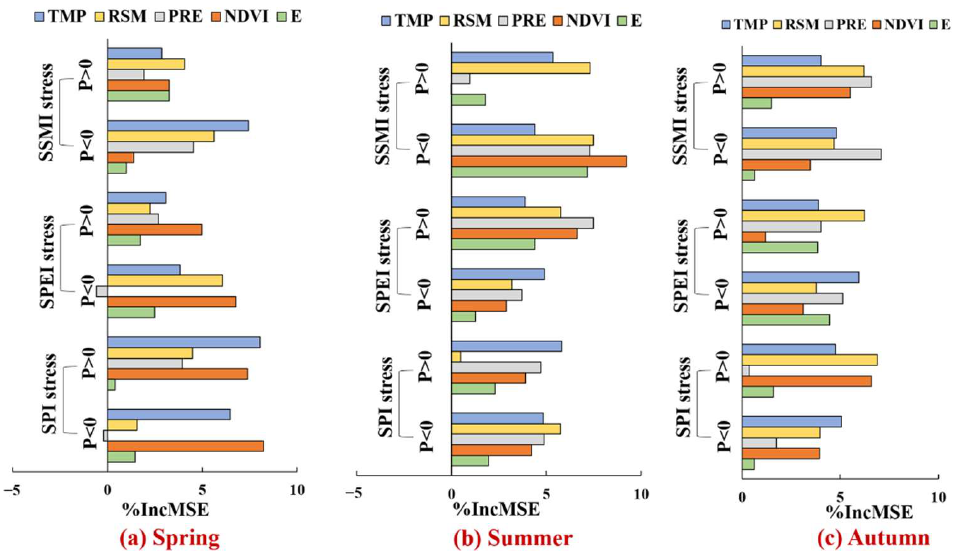
Figure 8. Importance score of different influencing factors on vegetation vulnerability changes under SPI/SPEI/SSMI stress: ( a ) spring, ( b ) summer and ( c ) autumn.